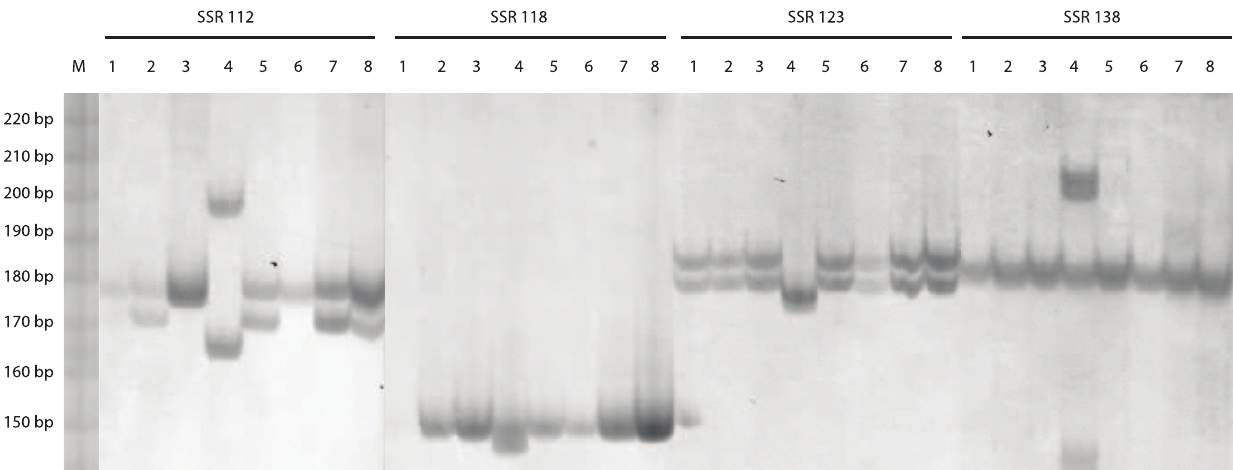
Figure 1. SSR alleles in eight Physalis genotypes and four polymorphic loci. The polymorphic SSR loci were visualized in 6% polyacrylamide gels, samples 1–8 correspond to the work code shown in Table 1. M=Molecular size marker, 10 bp DNA Ladder (Invitrogen, Carlsbad, CA).